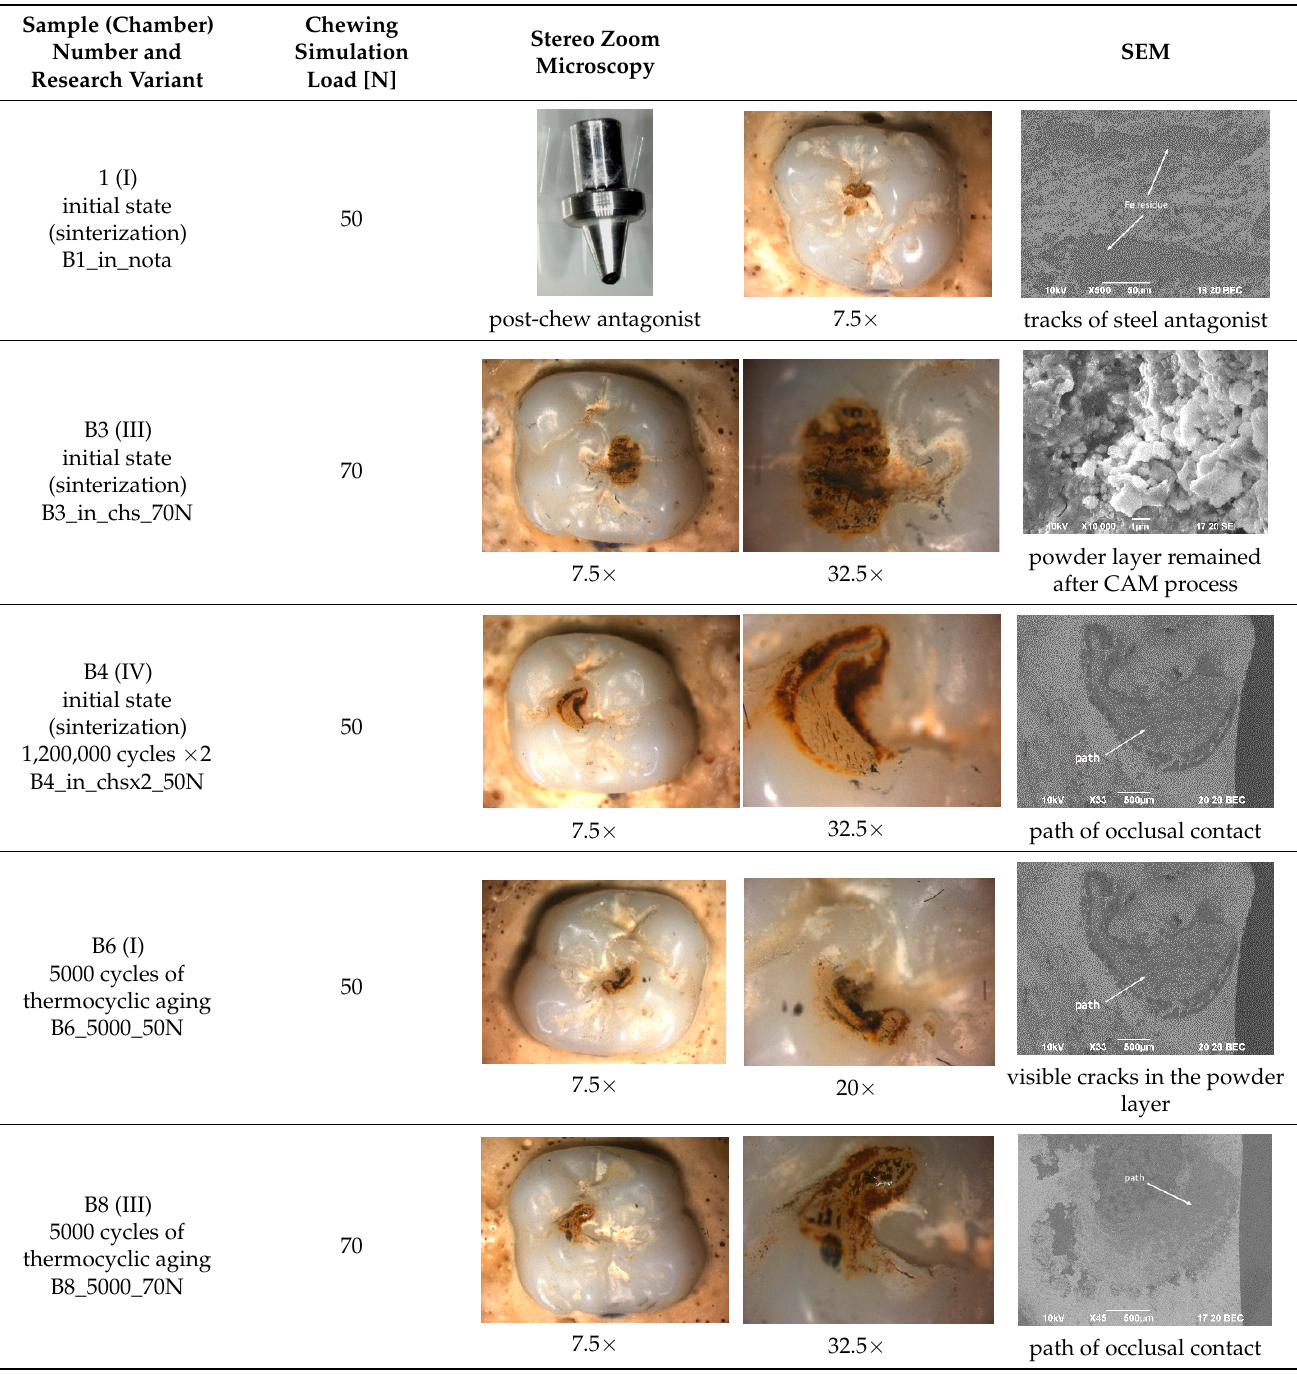
Table 2. Wear patterns of the zirconia crowns caused by contact with steel antagonists.